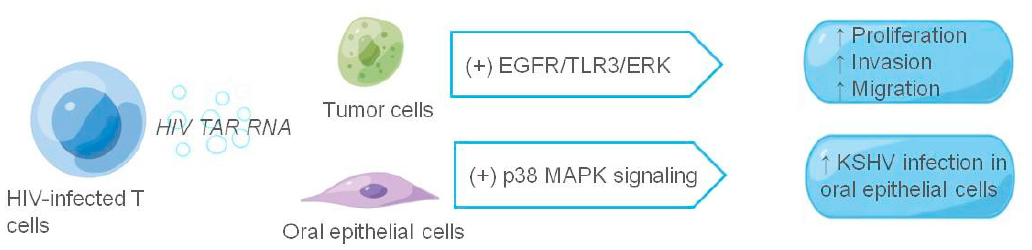
Figure 5. The role of exosomes in HIV-associated tumor microenvironment. The figure shows HIV- related components and their receptor cells at work in exosomes; HIV-related components are shown in italics, and ↑ indicates promotion.